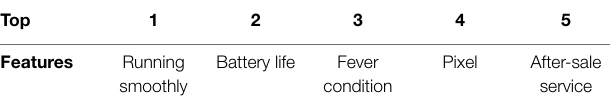
TABLE 5 | Top 5 features of mobile